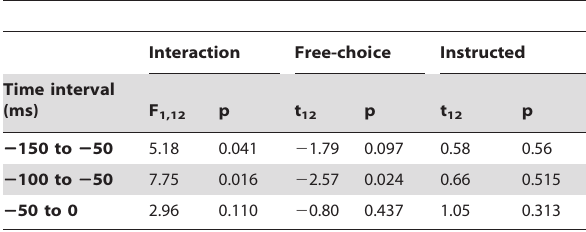
Table 1. Results of statistical analyses of ERP amplitudes in three 50 ms time